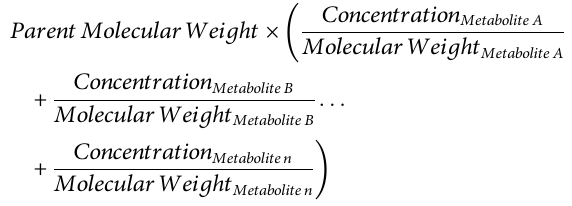
Frontiers in Genetics |